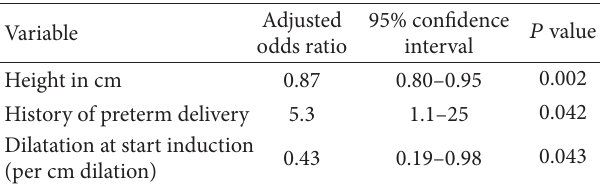
T 4: Multivariable analysis with adjusted odds ratios indicating the risk of cesarean